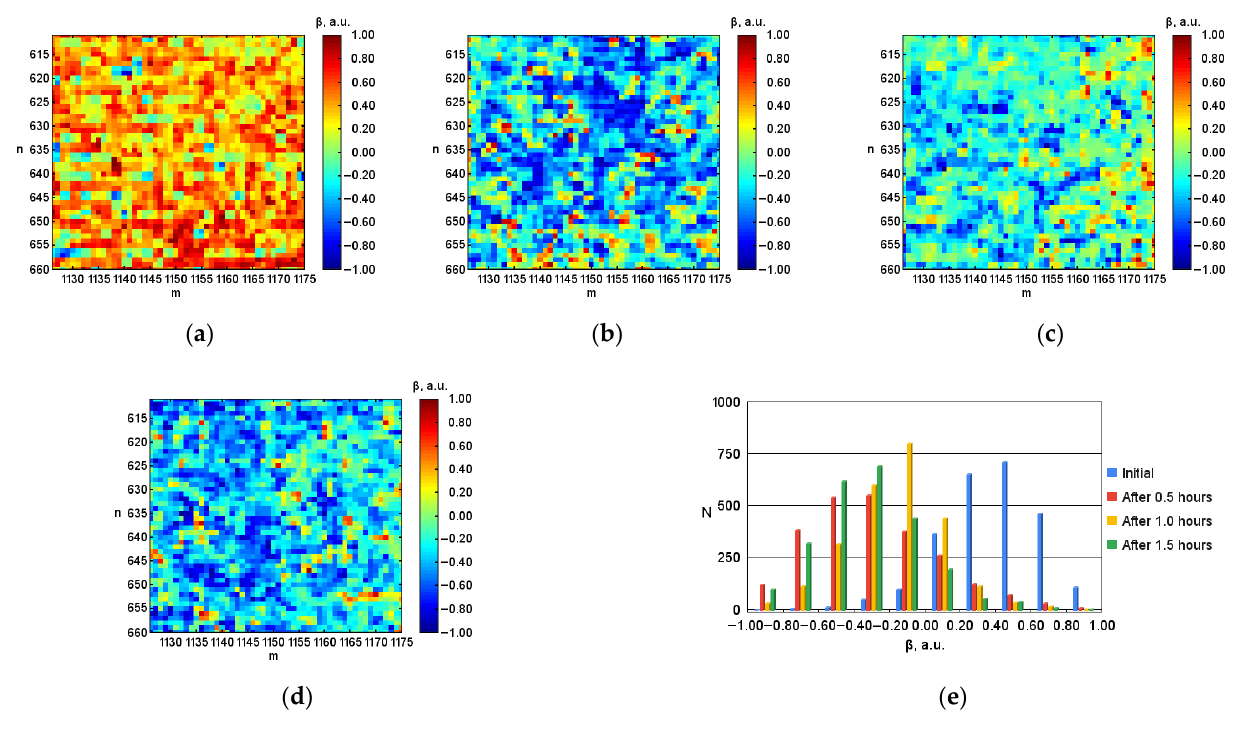
Figure 8. Coordinate distributions of the polarization (ellipticity) ellipse β , where: ( a ) is the initial hematocrit level; ( b ) is the hematocrit level after 0.5 h; ( c ) is after 1.0 h; ( d ) is after 1.5 h, and ( e ) the corresponding histograms of the object under investigation.